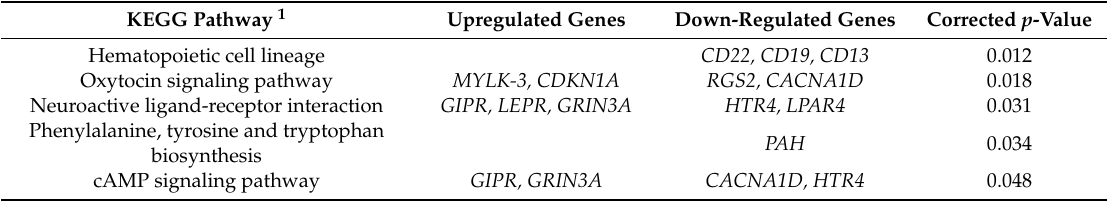
Table 3. Kyoto Encyclopedia of Genes and Genomes (KEGG) pathway analysis for DEGs identified in comparing the STH vs. GAM sheep.